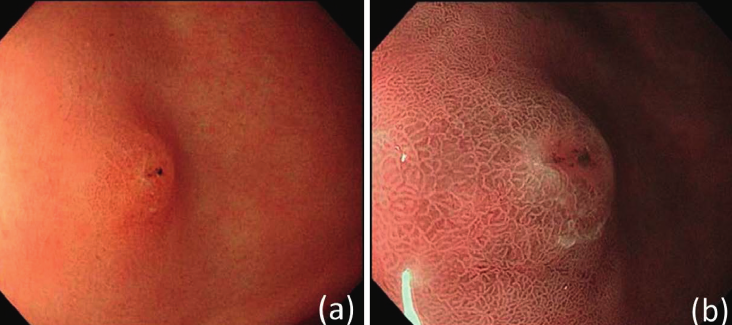
Figure 1: (a) A 5mm poorly demarcated pale-red elevated lesion observed in the anterior wall of the antrum against the background of nonatrophic H. pylori -negative mucosa. (b) Swelling of the glandular structures is present, although the demarcation line is unclear.